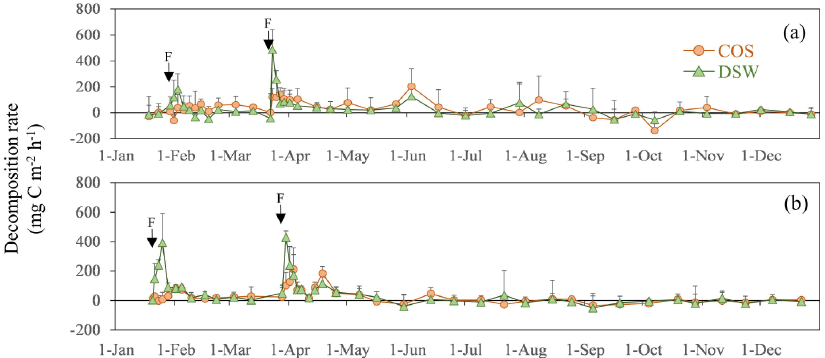
Figure 2. Decomposition rate of applied organic materials in 2013 ( a ); and 2014 ( b ) in no fertilizer (NF), combined organic and synthetic fertilizer (COS), and distilled silage waste (DSW) treatments in a citrus orchard in southwestern Japan. Error bars represent standard deviations. F denotes fertilization.